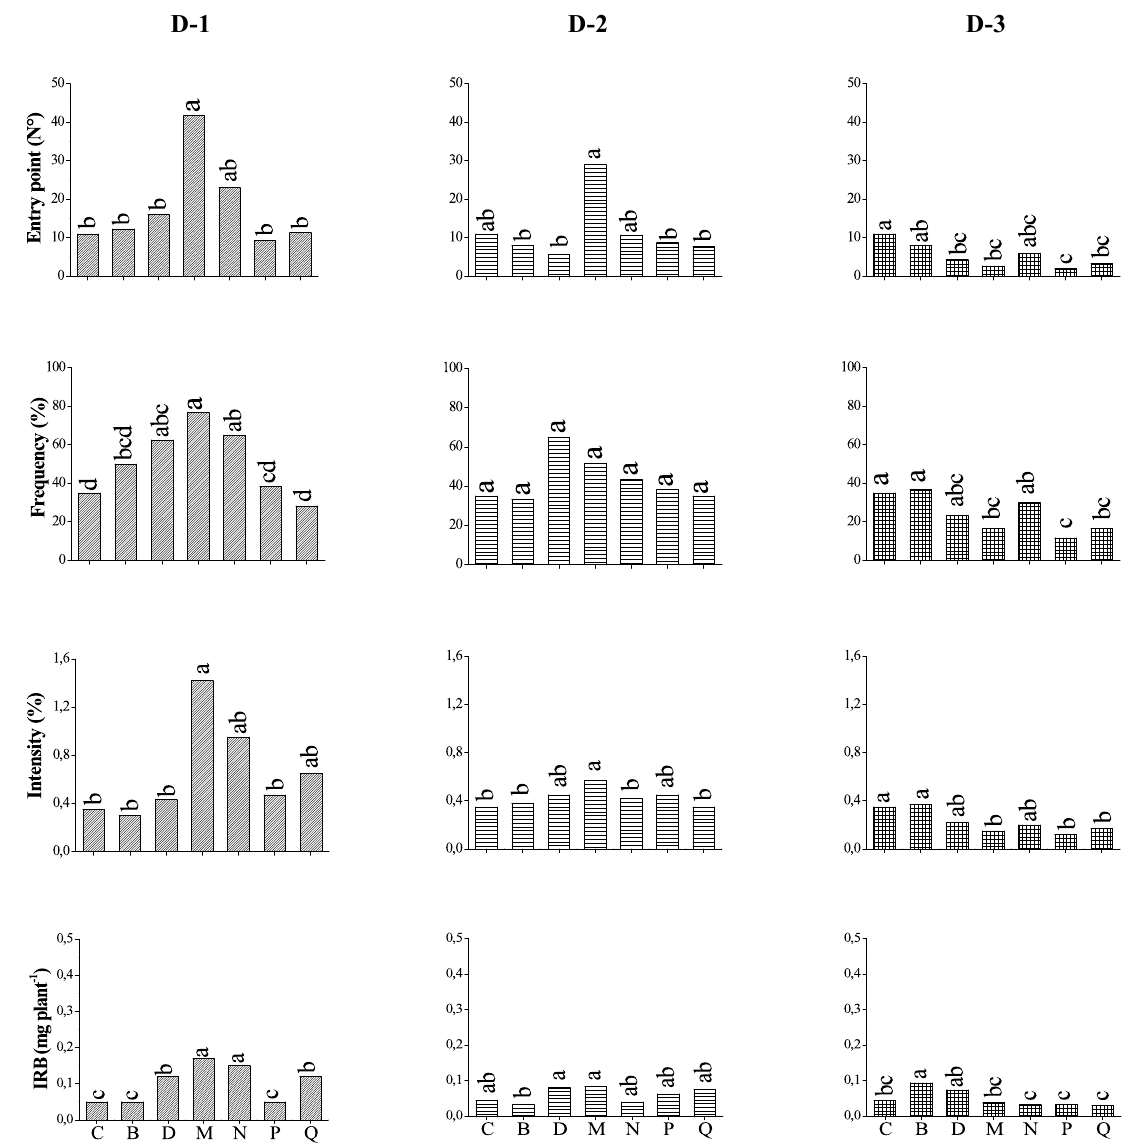
Fig. 2: Mycorrhizal colonization parameters: entry points, frequency of infection, infection intensity, and infected root biomass (IRB) in T. aestivum var. “Kumpa-INIA” with application of BorreGro (B), Dispher Alghum (D), Myconate (M), Natural Green (N), Pow Humus (P), Quick Sol (Q) and control without addition NP (C) at three concentrations: 0.1 mg mL -1 seed -1 (D-1); 1 mg mL -1 seed -1 (D-2), and 10 mg mL -1 seed -1 (D-3). Columns for each concentration sharing a letter in common do not differ significantly according to Duncan test